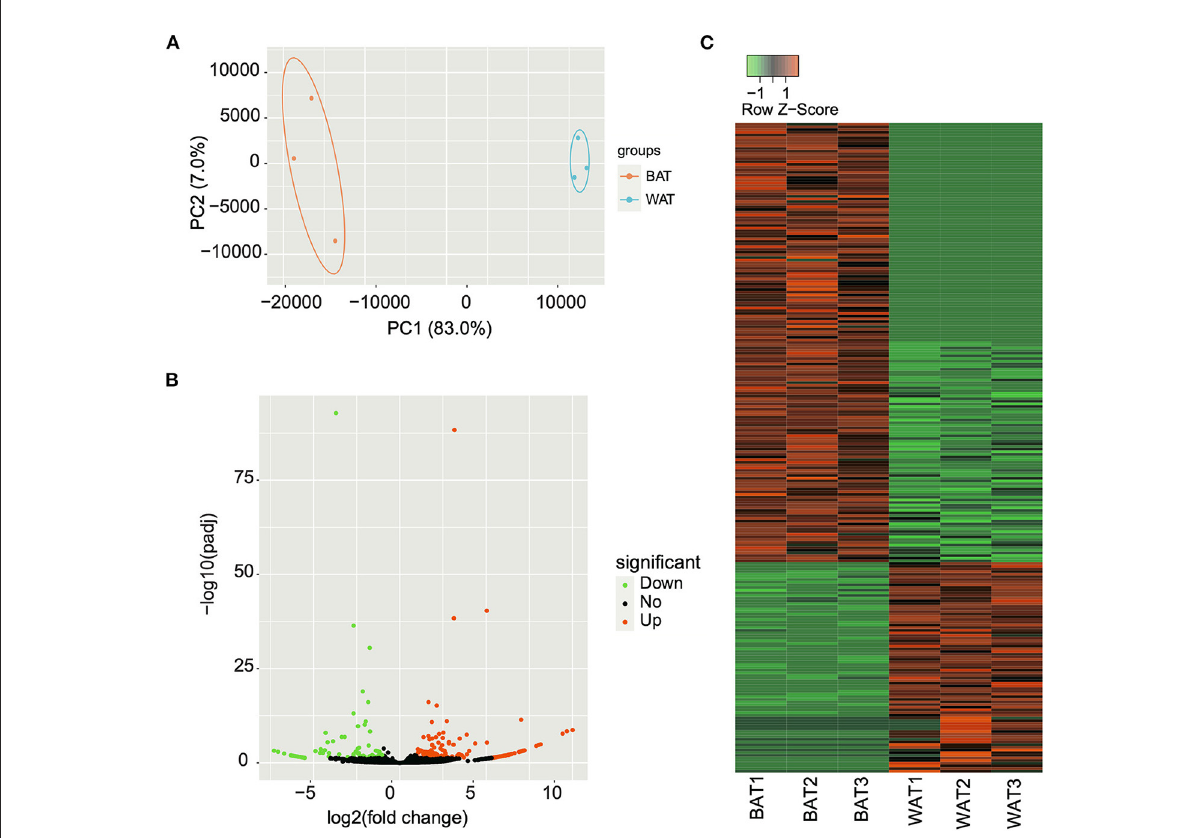
FIGURE3 Differentially expressed (DE) circular RNAs (circRNAs) between brown adipose tissue (BAT) and white adipose tissue (WAT). (A) Principal component analysis of the relative distances between BAT and WAT samples. (B) Volcano plot of DE circRNAs in BAT compared with WAT. The green, black, and red points represent downregulated, unchanged, and upregulated circRNAs, respectively. (C) Heatmap showing the expression changes of DE circRNAs in BAT and